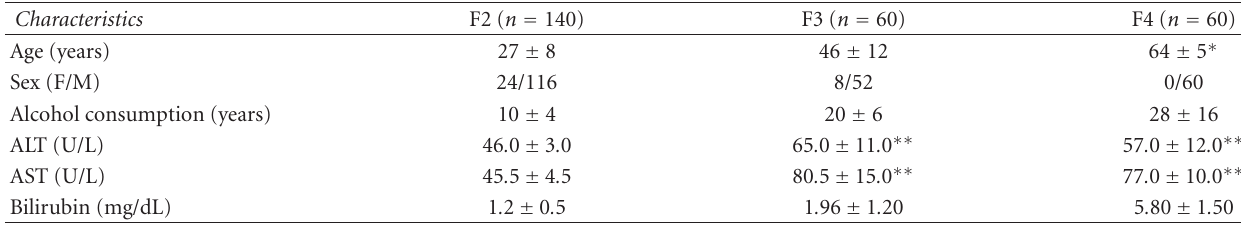
Table 1: Baseline characteristics ALD patients.